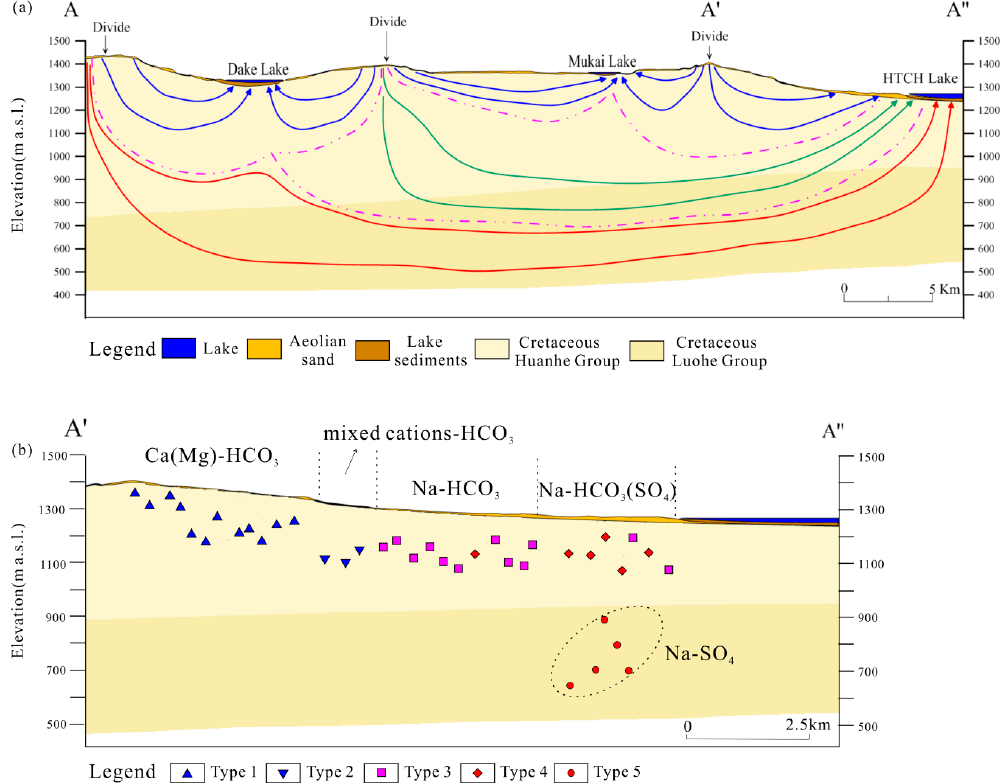
Figure 2. ( a ) A schematic hydrogeological cross section of A–A’’ in Figure 1c showing the hypothesis of hierarchically nested flow systems (local, intermediate and regional flow systems) controlled by wave topography: The blue, green and red solid lines with arrows indicate the local, intermediate and regional groundwater flow systems, respectively, and the pink dotted lines denote the boundaries of the different flow systems. ( b ) A schematic hydrogeological cross section of A’–A’’ showing the sampling sites of all 38 groundwater samples and the boundaries of the different five types of groundwater: Types 1, 2, 3, 4 and 5 represent Ca(Mg)–HCO 3 , mixed cations-HCO 3 , Na–HCO 3 , Na–HCO 3 (SO 4 ) and Na–SO 4 , respectively.